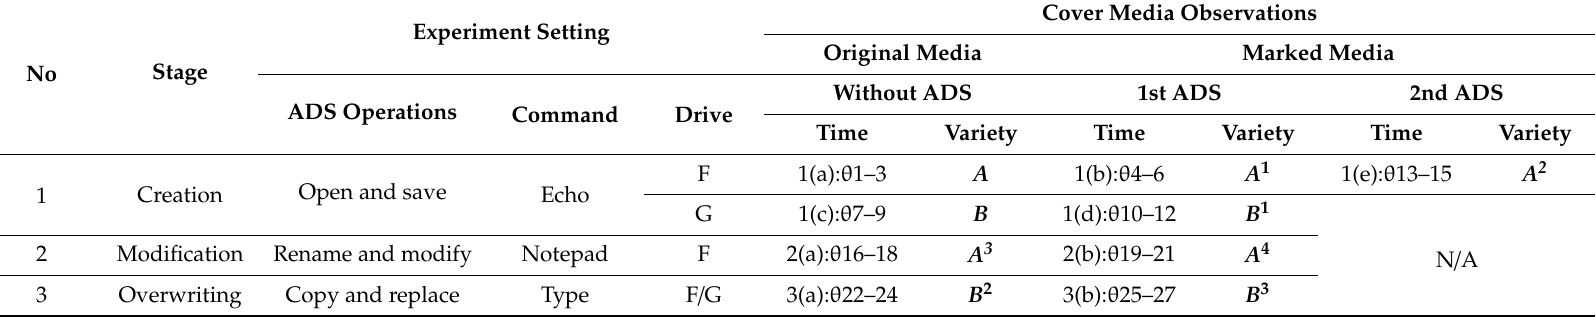
Table 5. Experiment setting and ADS observations.